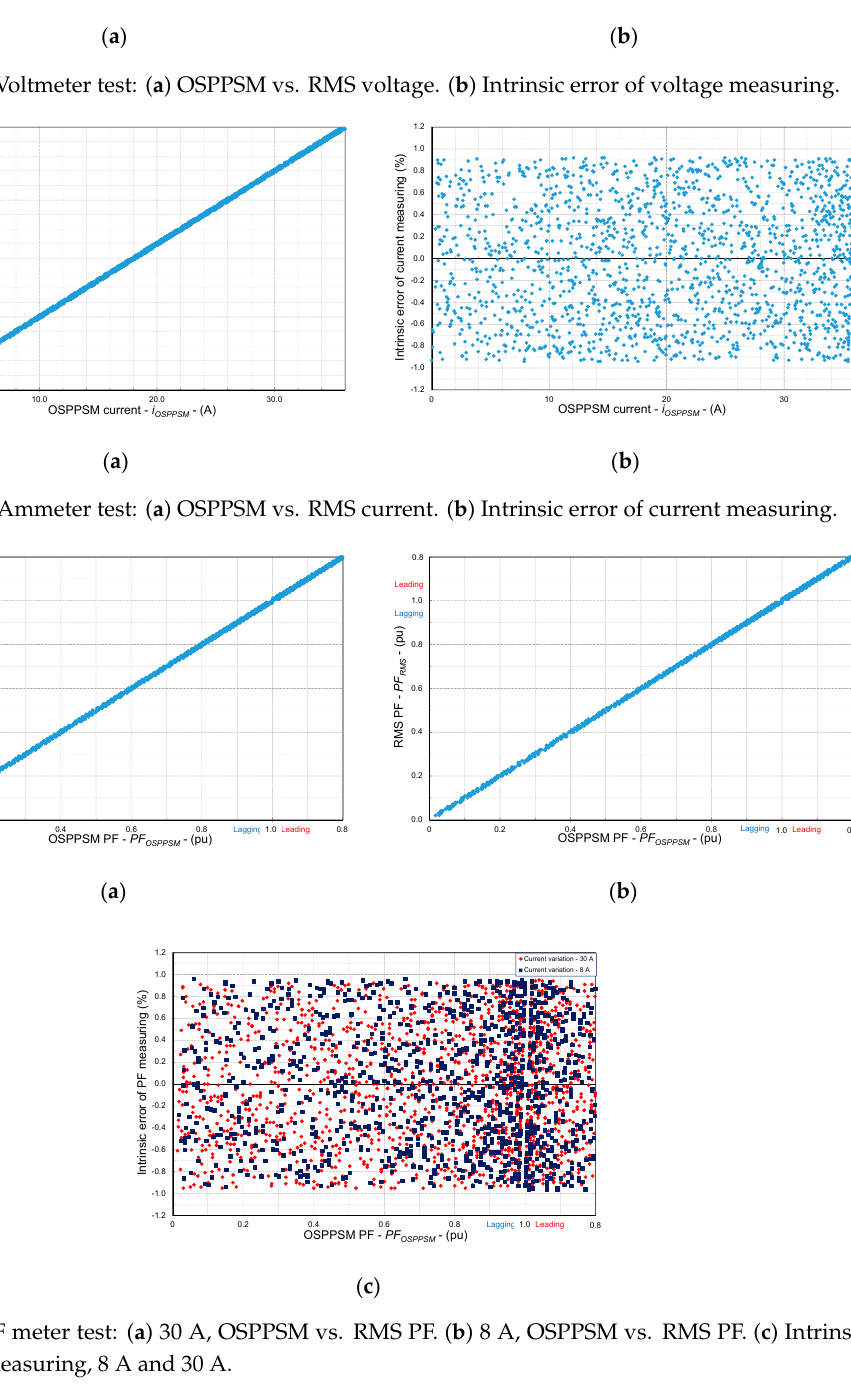
( b ) Figure 11. Wattmeter test: ( a ) OSPPSM vs. RMS active power. ( b ) Intrinsic error of active power measuring.